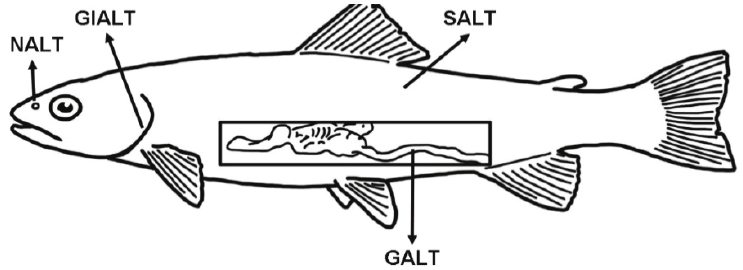
Figure 1. Schematic representation of the four teleost main mucosa-associated lymphoid tissues (MALT) described so far and their anatomical localization. GALT: gut-associated lymphoid tissue; SALT: skin-associated lymphoid tissue; GIALT: gill-associated lymphoid tissue; NALT: nasopharynx-associated lymphoid